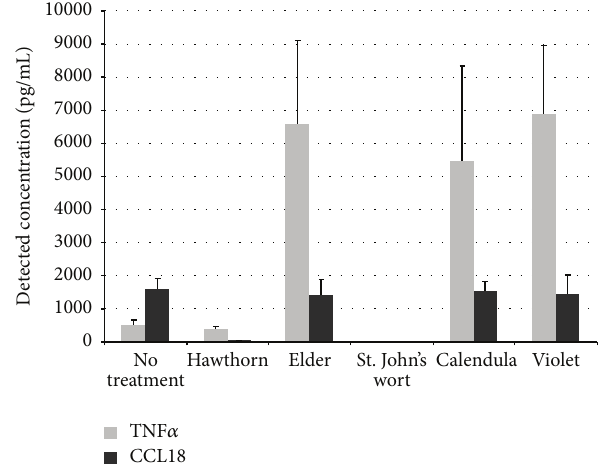
Figure4:Modulationofmacrophagepolarizationbynaturalagents. Macrophages were isolated from healthy subjects and brought into primary culture. Macrophages were incubated with extracts of various medicinal plants and stimulated with IFN- 𝛾 (100ng/mL) or IL-4 (10ng/mL). Secretion of TNF 𝛼 and CCL18 was measured by